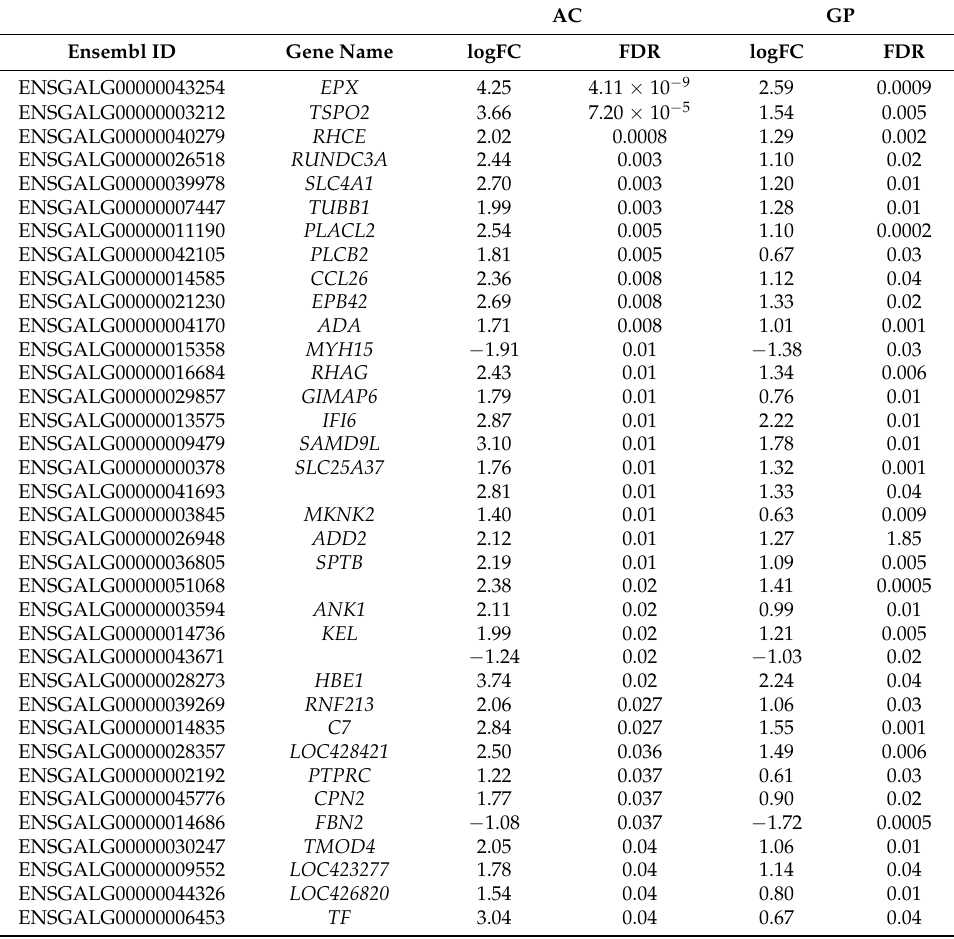
Table 3. Common differentially expressed genes between articular cartilage (AC) and femoral growth plate (GP) with information of the Ensembl ID, gene name, log2 fold change (logFC) and false discovery rate